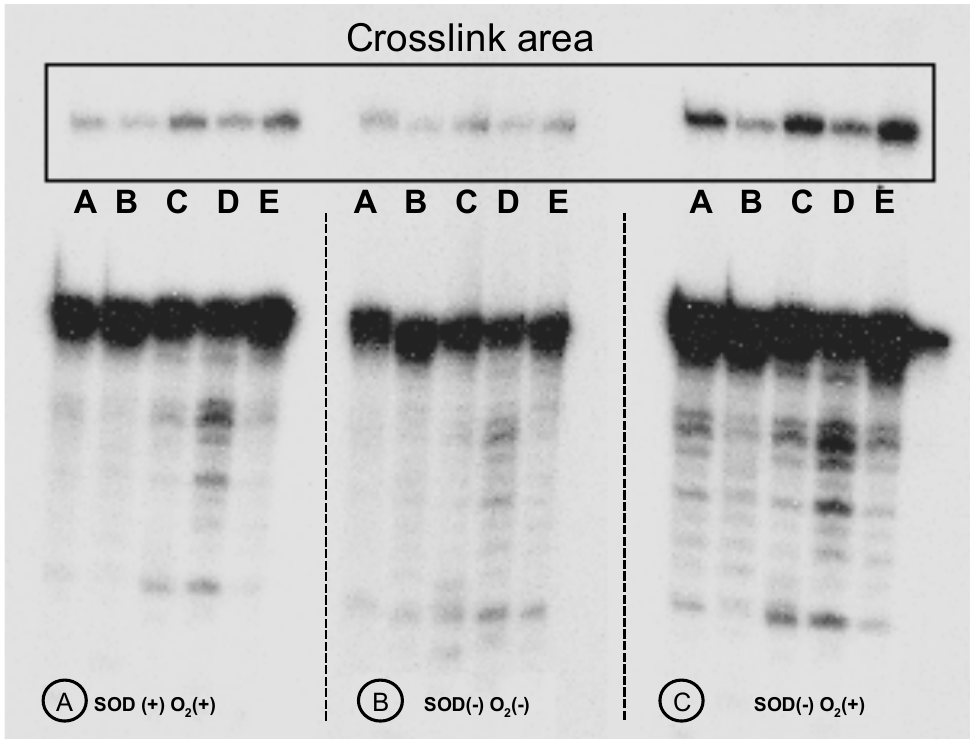
Figure 5: Autoradiogram of the results of irradiation of AQ-linked ds -DNA (A–E) after piperidine treatment: A) in the presence of oxygen and SOD, B) in the absence of oxygen and SOD, C) in the presence of oxygen and absence of